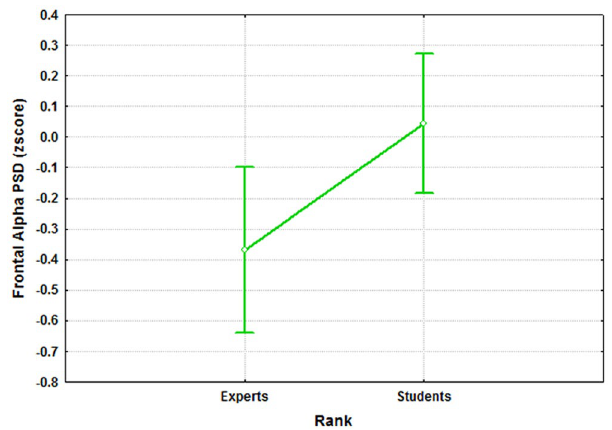
Figure 11. The figure reports the results of the ANOVA analysis (CI = 0.95) on the frontal alpha PSD with the factor “RANK” of 2 levels (Experts and Students). The results showed that the two groups were statistically different (p = 0.024) in terms of activation of the frontal alpha rhythm when facing the same S, R and K events.